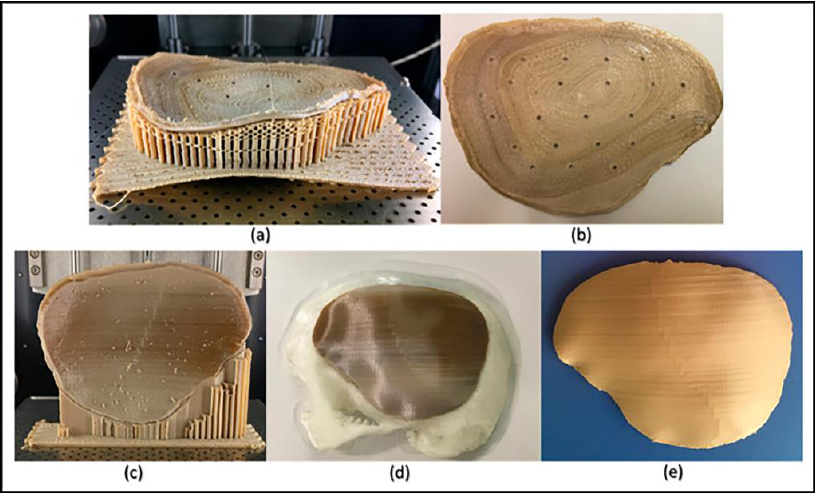
Figure 3. Illustrations of the FFF PEEK 3D printing issues in the cranial implants regarding differ- ent orientations. ( a ) Horizontally printed cranial implant showing the raft detachment/warping effect (in situ); ( b ) horizontally printed cranial implant displaying a rough internal surface; ( c ) vertical printed cranial implant exhibiting different levels of crystallinity (in situ); ( d ) 3D-printed skull biomodel with the vertically printed implant after support structure removal; and ( e ) annealed vertically printed cranial implant displaying no discolorations [23]. Reproduced under the Creative Commons Attribution License permission from an open access Journal of Clinical Medicine pub- lished in 2020.